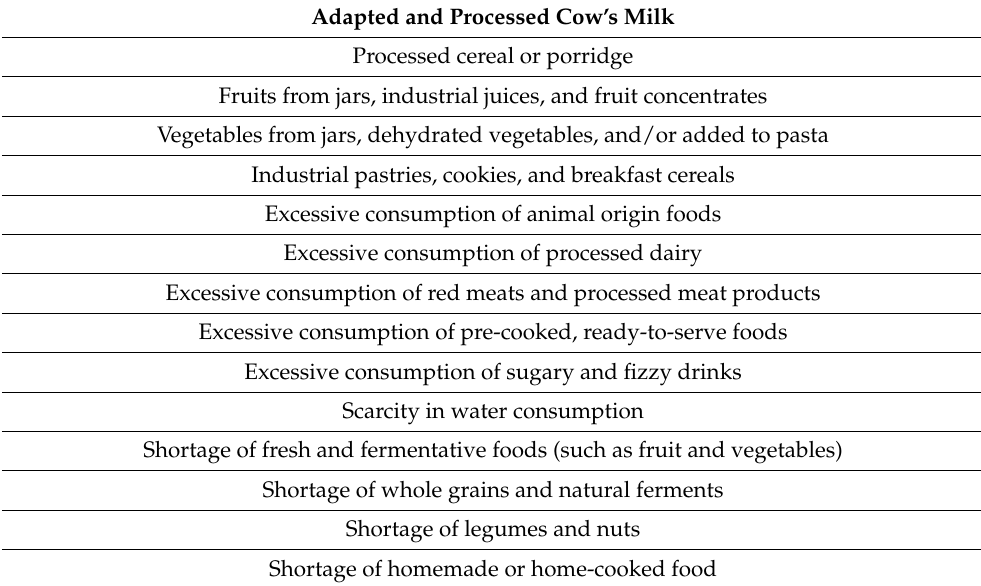
Table 3. Prototype diet accepted by ‘Western civilisation’ at one year of